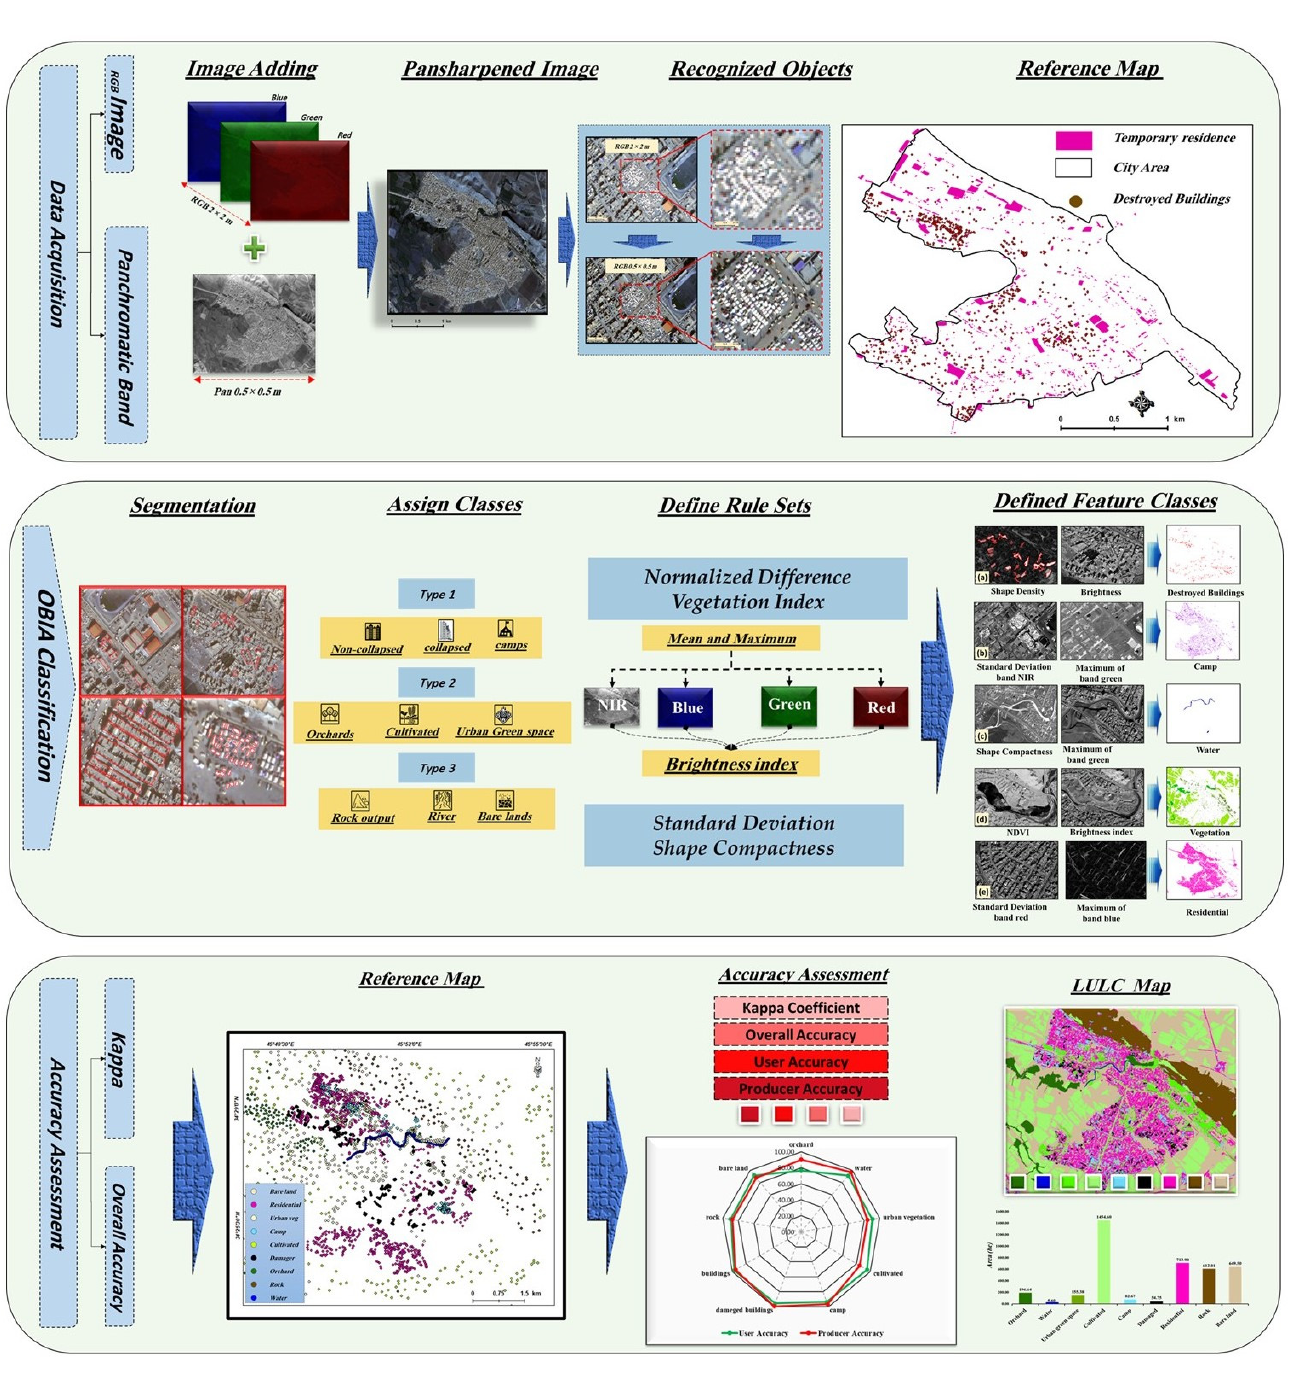
Figure 3. Flowchart of the research process. As it can be observed from the figure, the process started with image input, segmentation, applying the object-based features, classification and validation as main steps of the research scheme.